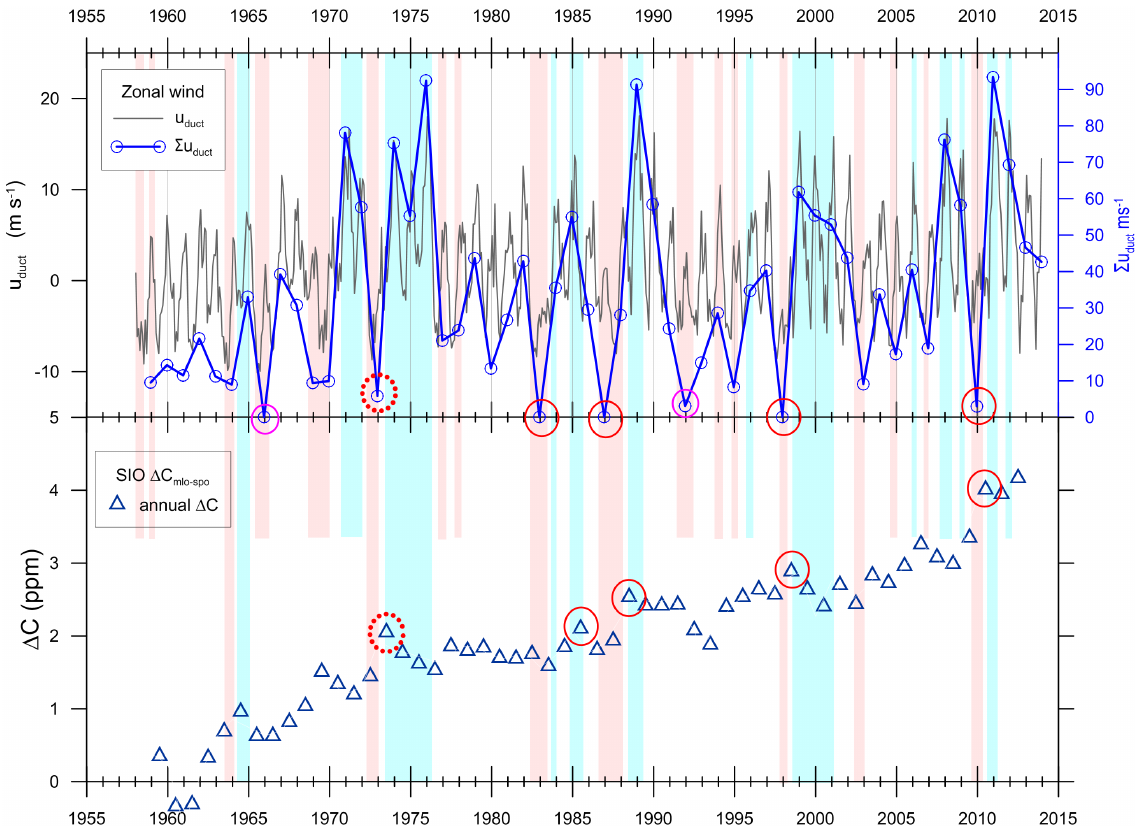
Figure 7. Interhemispheric mlo–spo differences from the historic Keeling CO 2 record and u duct : the top panel shows monthly u duct (300hPa, 5 ◦ N to 5 ◦ S, 140 to 170 ◦ W), with red and blue bands indicating El Niño and La Niña periods respectively (left axis). The relative strength and duration of NH winter (October to April) IH mixing is estimated by (cid:54)u duct , plotted in January (right axis). In the bottom panel annual average mlo–spo (cid:49) C are shown. Red circles indicate occasions when integrated duct transport is <5ms − 1 , dashed for >5ms − 1 , and smaller circles (in the top panel) indicate occasions when brief closures are not followed by La Niña and there is no detectable (cid:49) C